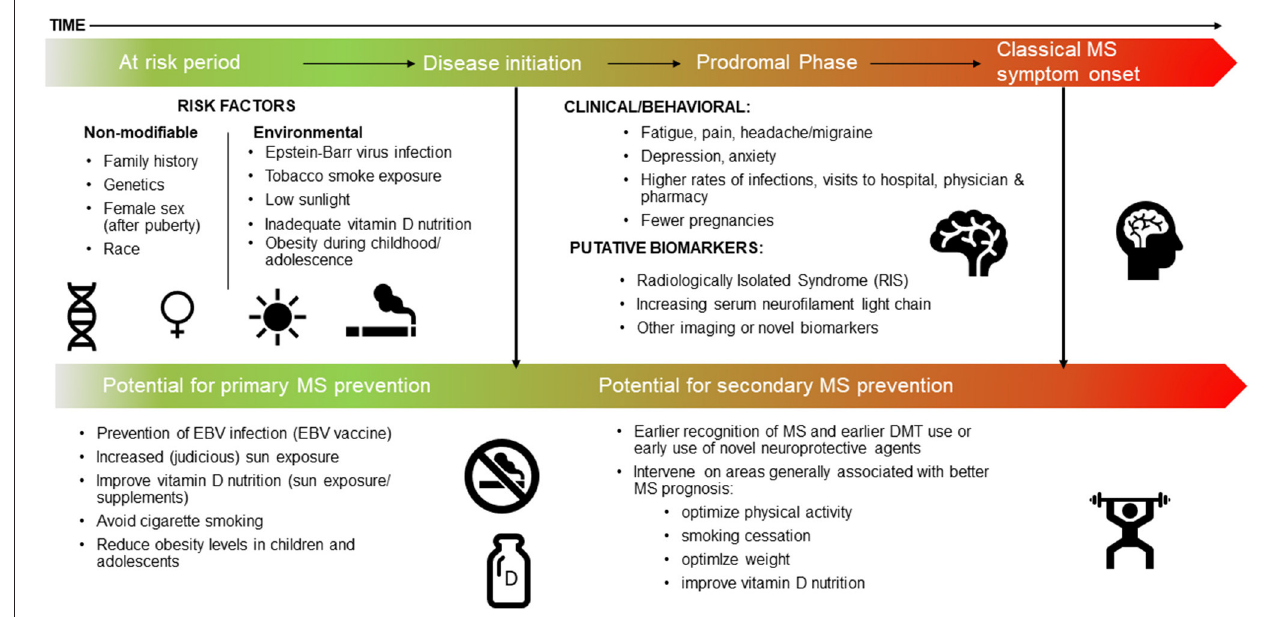
FIGURE 1 | The MS continuum, a proposed timeline: the at risk period, the prodrome, and potential for prevention.